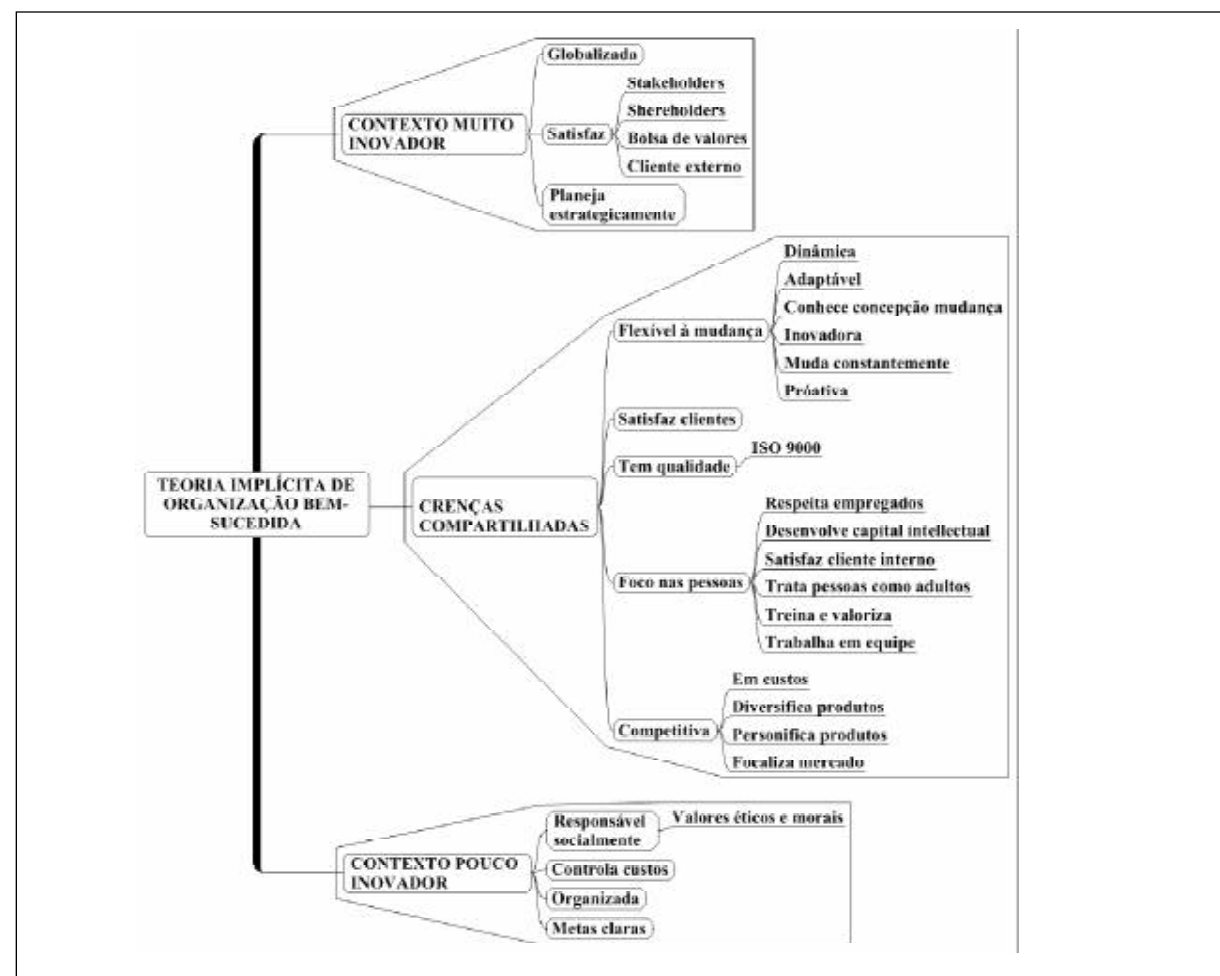
Figura 1 . Teoria implícita de organização bem-sucedida segundo a percepção de atores inseridos em contextos muito e pouco